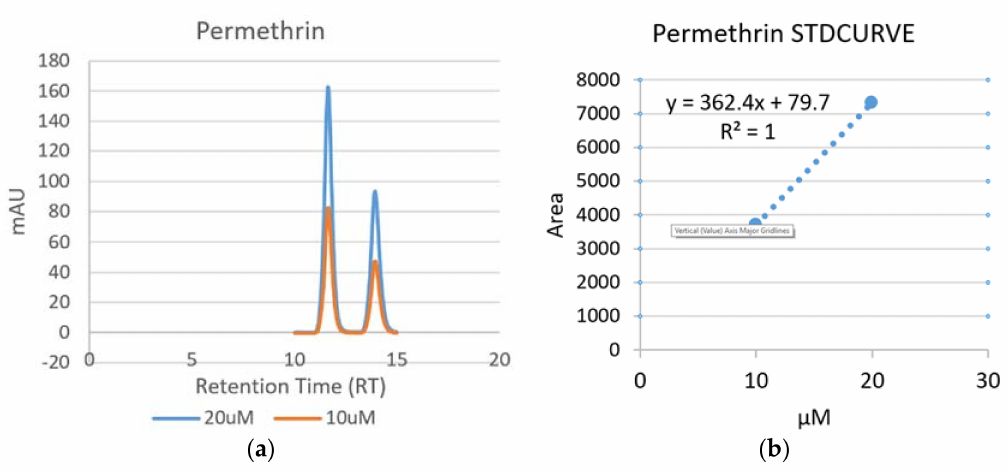
Figure 4. Chromatogram ( a ) and standard curve ( b ) of Permethrin.